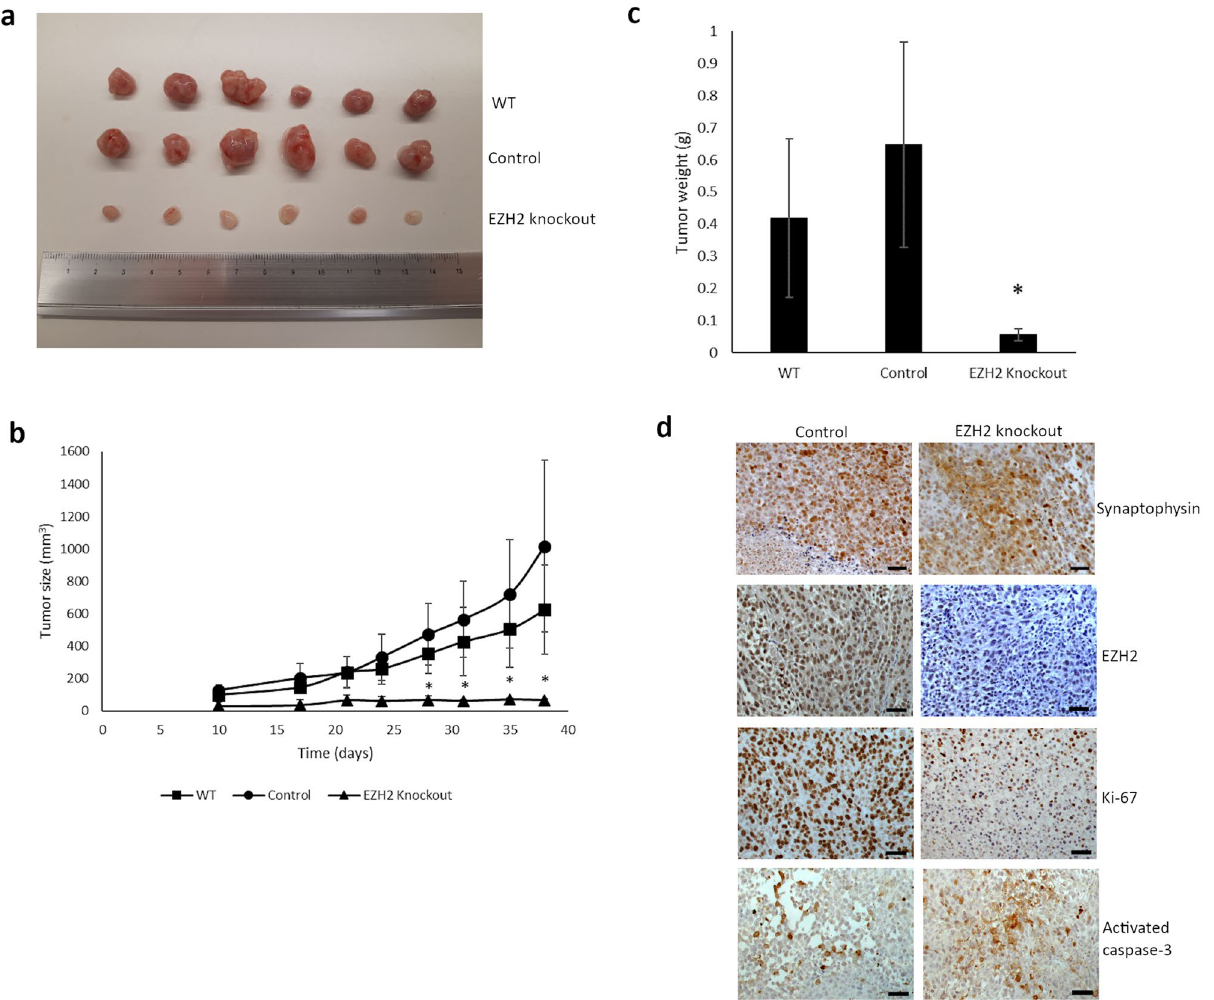
Figure 3. EZH2 knockout in vivo. ( a ) NMRI-nude female mice (n = 18) were randomly distributed into three groups, and CNDT2.5 WT, control or EZH2 knockout cells were subcutaneously inoculated in the hind flank of the mice. The tumors were dissected after 38 days. ( b ) Tumor volume was monitored by caliper measurements. Six mice per group were used, and the data represent means ± SD. ( c ) Xenograft tumor weight is